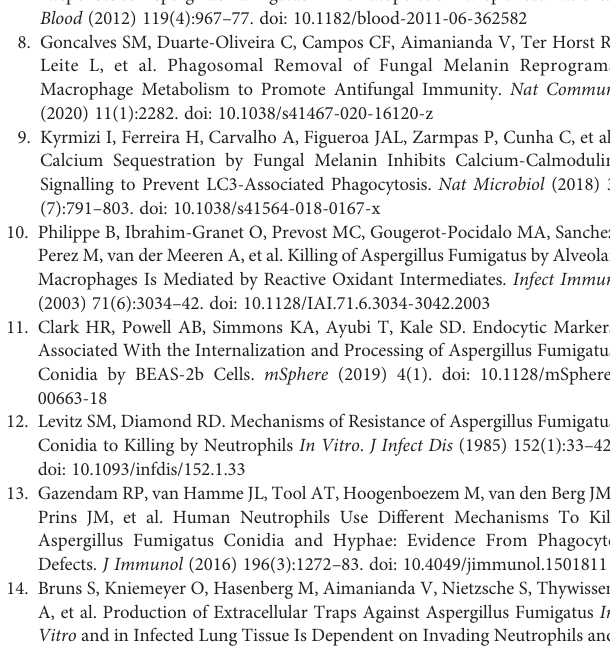
by wildtype BMDMs to stimuli (killed conidia, zymosan depleted, zymosan, curdlan, and control PBS) over 9 hours. Wildtype and Nlrx1-/- BEAS-2B cells were then treated with either (B, H) curdlan, (C, I) zymosan depleted, (D, J) zymosan, (E, K) killed conidia or (F, L) control PBS buffer over 9hrs. Fluorescence was measured at